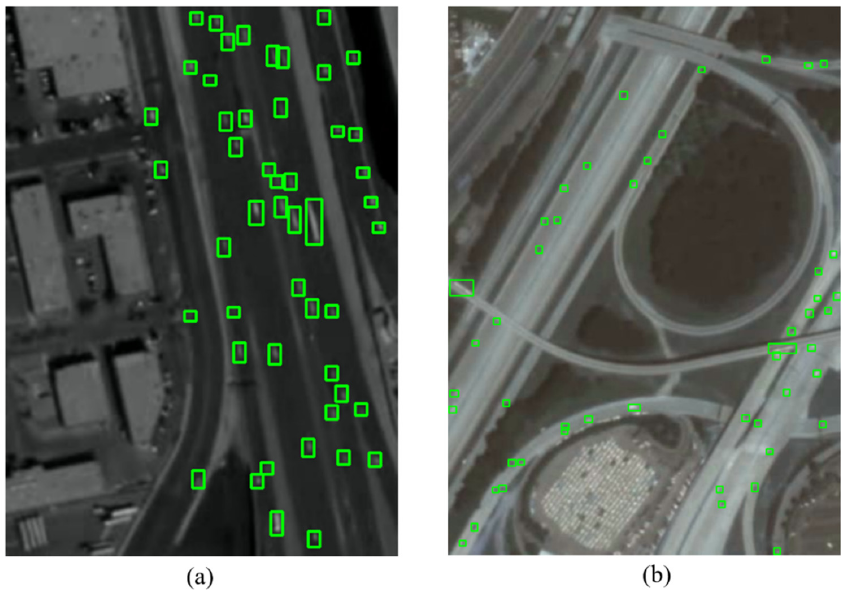
Figure 8. Enlarged parts of the video data and manually annotated ground ‐ truth vehicles. Image ( a ) shows the SkyBox satellite data [13], and ( b ) shows the ChangGuang satellite data.